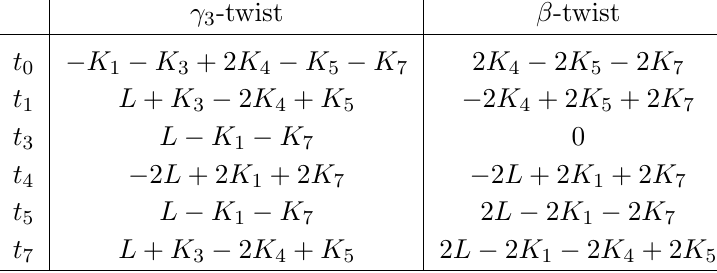
Table 4 . Twist factors for the ABA Bethe